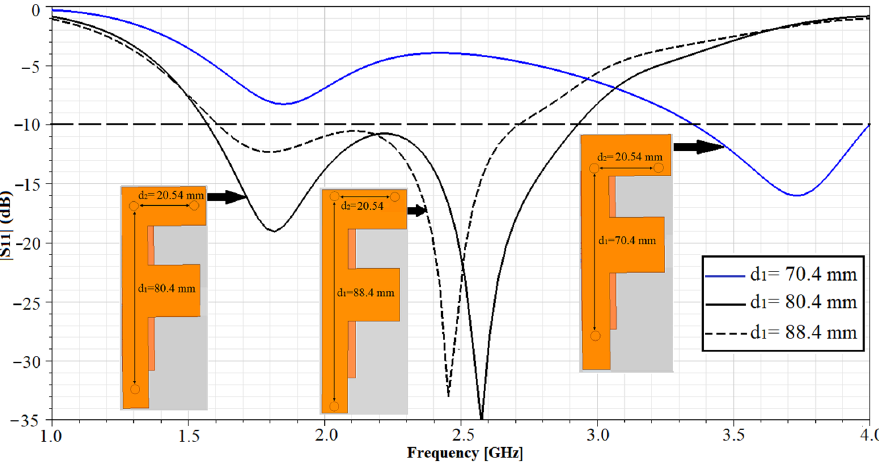
Figure 10. Variation of reflection coefficient |S 11 | with respect to the shorting pins’ positions (d 1 ).